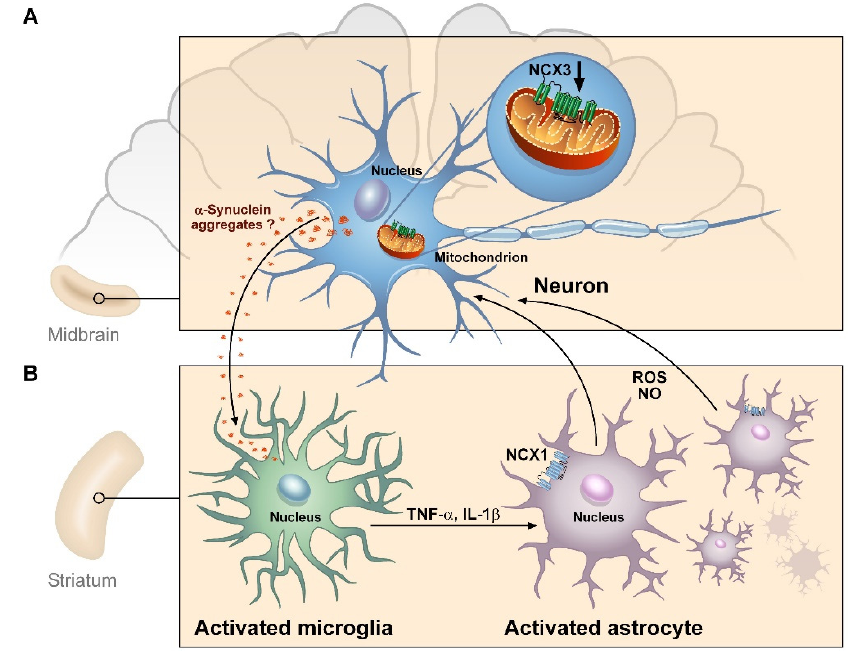
Figure 5. Schematic model illustrating the cellular and molecular events leading to neuroinflammation in A53T- α -syn mice. ( A ) The NCX3 impaired expression in the midbrain leads to mitochondrial dysfunction in dopaminergic neurons with consequent cellular damage and release of toxic factors (probably aggregated α -syn) able to induce microglial cells’ activation in the striatum. ( B ) The microglial activation in the striatum may induce pro-inflammatory cytokines’ release that in turn stimulates NCX1-driven astrocyte proliferation. Finally, the activated astrocytes in the striatum may invade the midbrain, further contributing to dopaminergic neuronal damage.